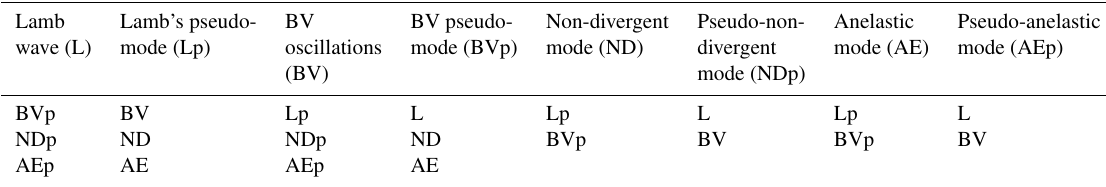
Table 2. The coincidence of the evanescent mode properties at the intersection points of the dispersion curves. Note: the bottom rows show the modes that are indistinguishable from the corresponding mode of the top row at the point of intersection of the dispersion curves.